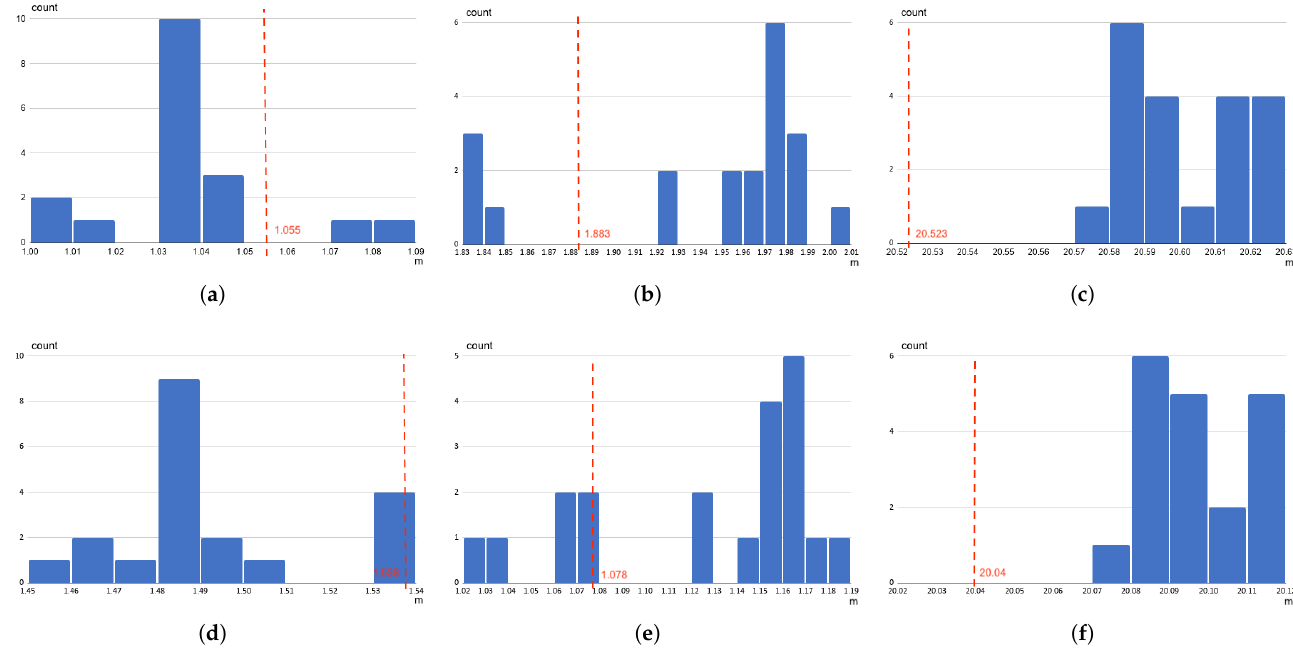
Figure 9. Histograms of 20 measurements: The histogram represents the actual crane position of each moving subsystem and for each of the two selected targets, which are marked in vertical dashed lines. ( a ) Target 1 measurement—Hoist (Y); ( b ) Target 1 measurement—Bridge (Z); ( c ) Target 1 measurement—Trolley (X); ( d ) Target 2 measurement—Hoist (Y); ( e ) Target 2 measurement—Bridge (Z); ( f ) Target 2 measurement—Trolley